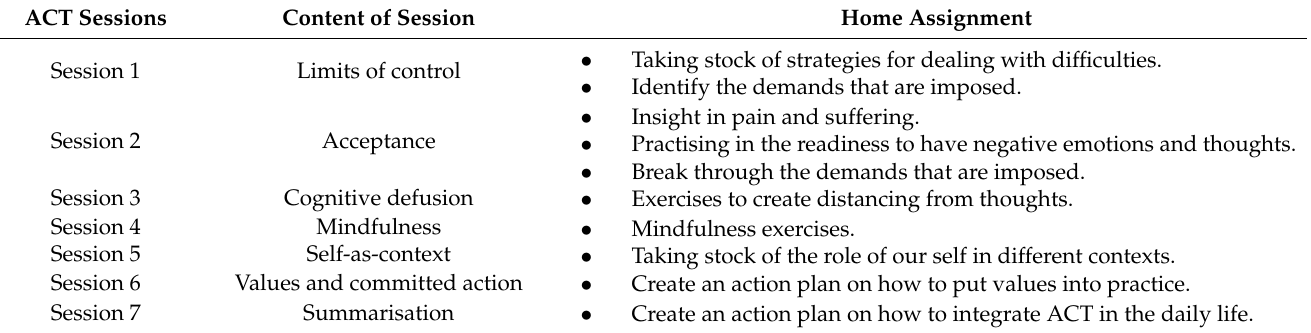
Table 1. Content of Acceptance and Commitment sessions, with corresponding home